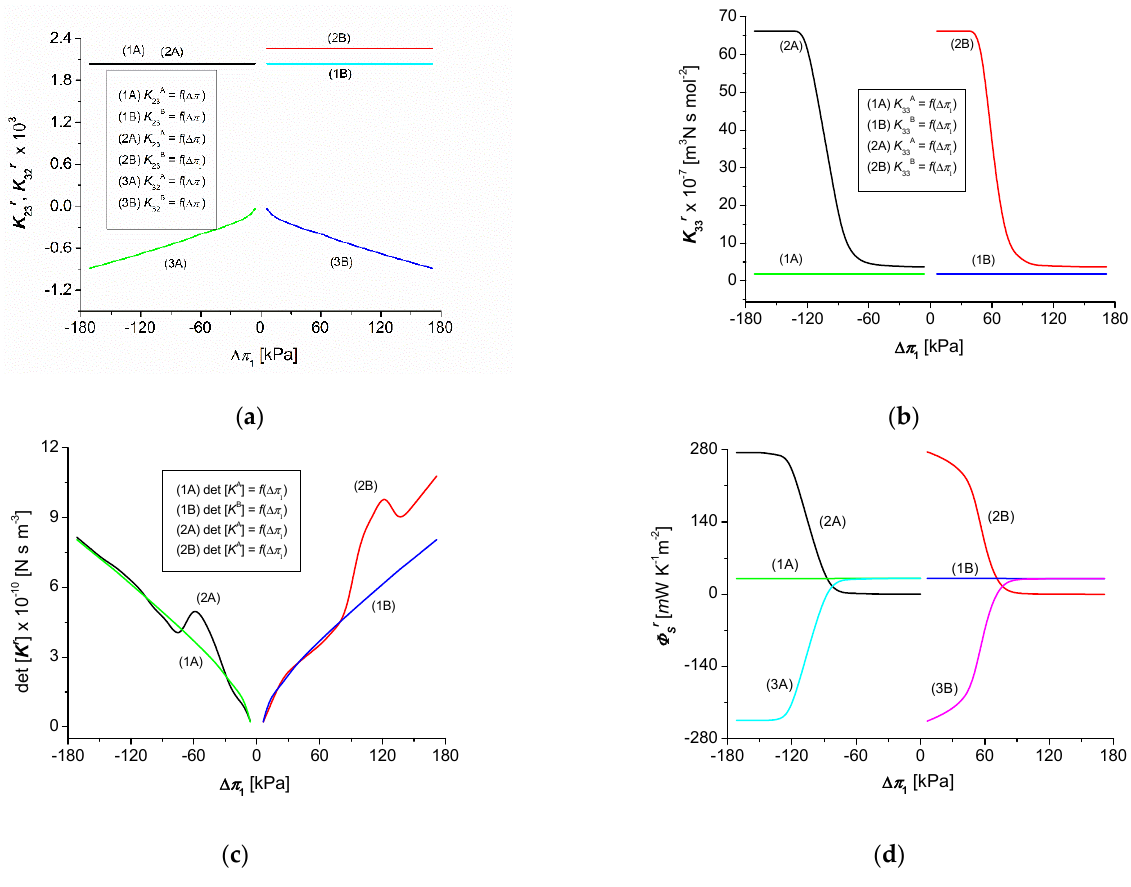
Figure 6. Coefficients 𝐾 (cid:3036)(cid:3037)(cid:3045) and 𝐾 (cid:3031)(cid:3032)(cid:3047)(cid:3045) ( i , j ∈ {1, 2, 3}, r = A, B) as functions of glucose osmotic pressure difference ( ∆𝜋 (cid:2869) ) and ∆𝜋 (cid:2870) = 490.2 kPa: 𝐾 (cid:2870)(cid:2871)(cid:3045) and 𝐾 (cid:2871)(cid:2870)(cid:3045) ( a ), 𝐾 (cid:2871)(cid:2871)(cid:3045) ( b ), 𝐾 (cid:3031)(cid:3032)(cid:3047)(cid:3045) ( c ), and total production of entropy 𝜑 (cid:3020)(cid:3045) ( r = A, B) ( d )